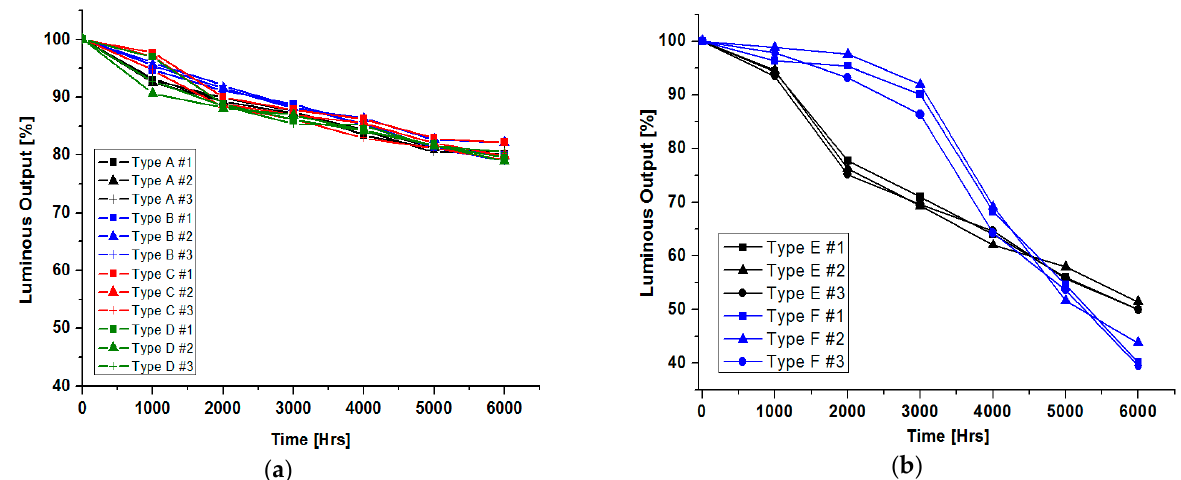
Figure 2. Characteristics of maintained lumen output of OLED products. ( a ) Maintained lumen output of OLED panels. ( b ) Maintained lumen output of OLED luminaires.